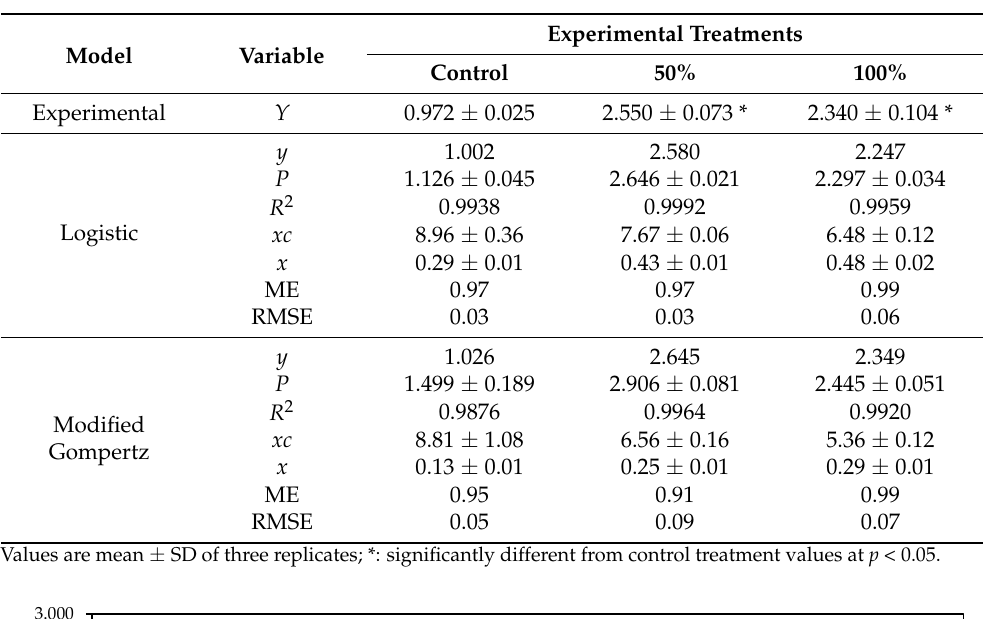
Table 1. Growth kinetic parameters of C. vulgaris cultivated in different concentrations of mushroom farm wastewater.